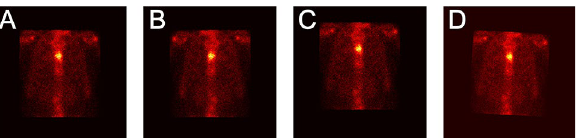
Figure 4. Examples of preprocessing a thoracic image with a hot pot of bone metastasis in the spine. ( a ) The original thoracic image; ( b ) the mirrored image; ( c ) the vertically translated image; and ( d ) the rotated image.